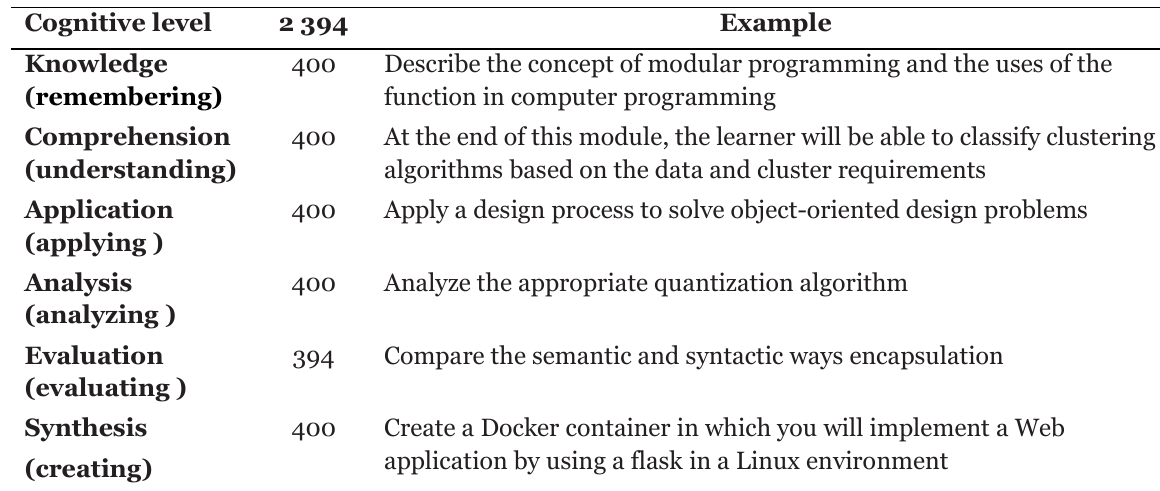
The Distribution of LOs in Our Dataset